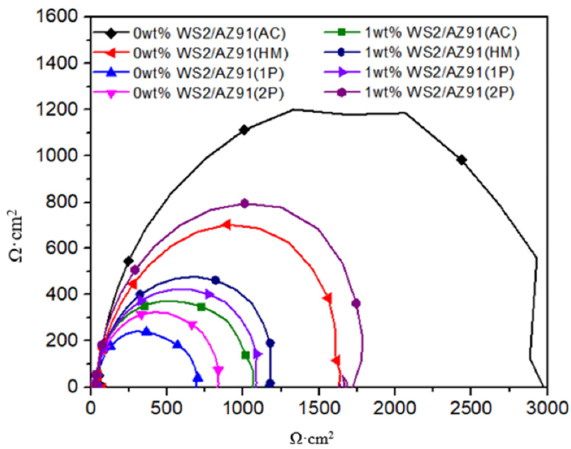
Figure 5. Comparative Nyquist plots for WS2/AZ91 composites.